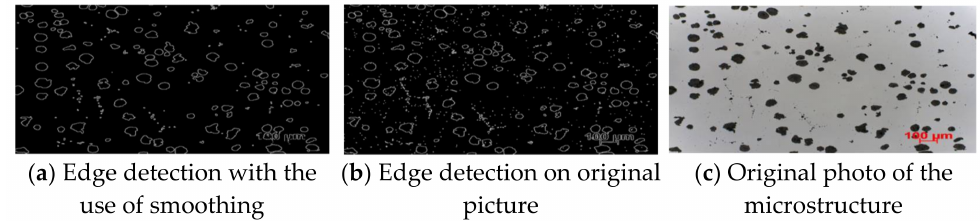
Figure 5. Edge detection with Canny